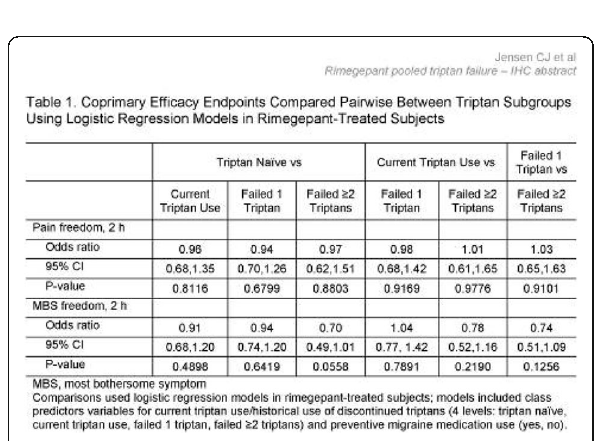
Table 1 (abstract P0268). See text for description